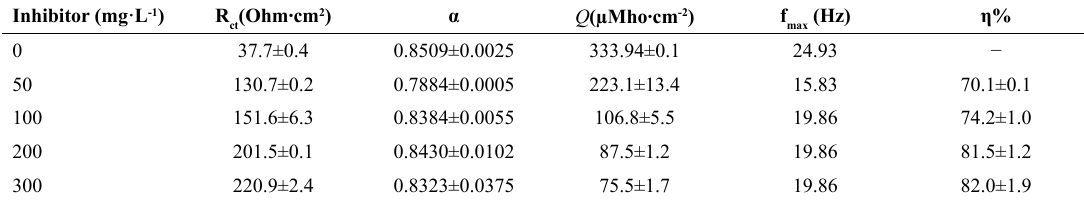
Table 3. Electrochemical parameters obtained from EIS plots for C-steel in 1.0 mol∙L -1 HCl without and with ethanolic Aniba canelilla extract at the following concentrations: 0, 50, 100, 200 and 300 mg∙L -1 . Inhibitor (mg·L -1 )